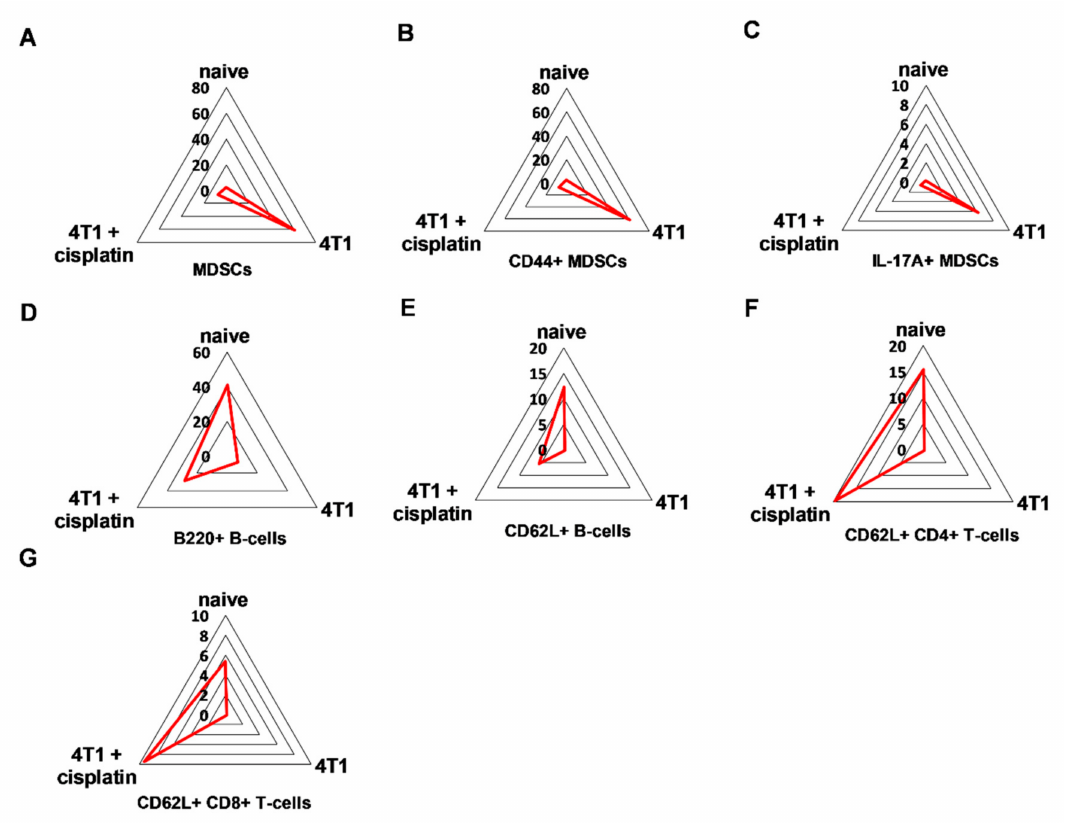
Figure 6. The trajectories on the radar plots delineate the characteristic marker profile of splenocytes in naive, 4T1 tumor bearing, and cisplatin treated tumorous mice. The accumulation of splenic ( A ) CD11b +/ Gr-1 + MDSCs, ( B ) CD44 + , and in a smaller extent ( C ) IL-17A + MDSCs is a characteristic of 4T1 breast cancer. Cisplatin restores the percentage of ( D ) B220 + and ( E ) CD62L + B-cells, ( F ) CD62L + CD4 + and ( G ) CD8 + T-cells. The percentage of the given populations is demonstrated on the radar plots within the CD45 + living singlets determined by manual gating in Cytobank. The gating hierarchy is explained in the text and in Figure S3. The markers of the panel which were not detected or did not show di ff erential expression are not shown. Representative radar plots are shown from the pooled samples of 6 mice per group as described in Section